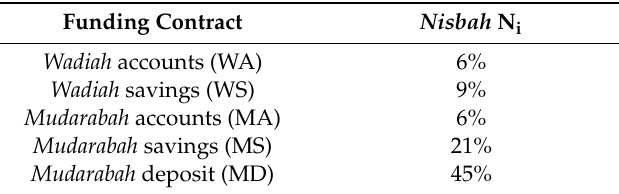
Table 3. Share proportion ( nisbah ) of funding